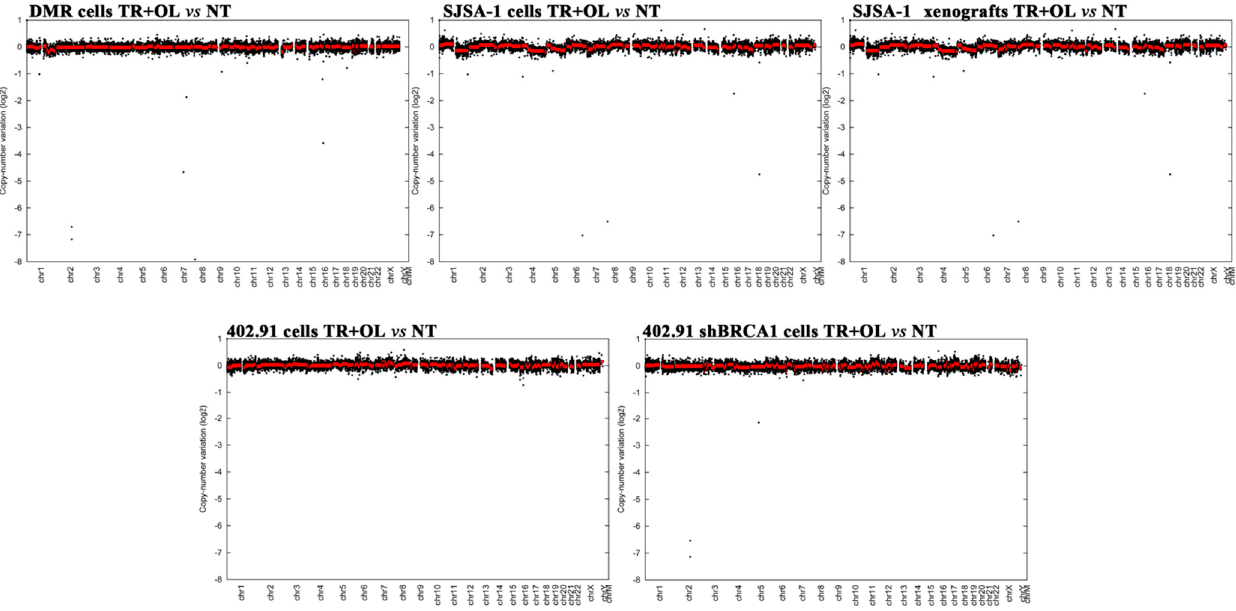
Figure 4. Copy number alterations calculated on WES data output after trabectedin + olaparib (TR + OL) treatment in DMR, SJSA-1, and SJSA-1 xenografts, 402.91, and 402.91 with stable silenced BRCA1 compared to relative untreated controls. Results are shown as Log2 variations in copy number (treated vs. untreated samples), plotted against chromosomal locations.